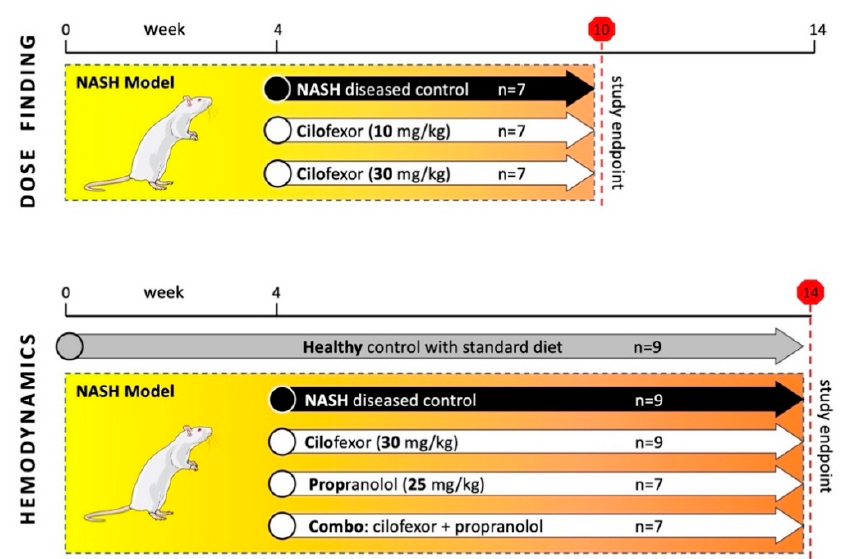
Figure 1. Study design and treatment groups. The NASH model was induced by choline-deficient high-fat diet and injection of NaNO 2 3 × /week. Initially, a 10-week long dose-finding study was performed with three groups of 7 rats each. The animals received placebo treatment, 10 mg/kg or 30 mg/kg of cilofexor (CILO), respectively, from weeks 4–10. In a subsequent, 14-weeks-long study, four NASH groups ( n = 7–9) received placebo, 30 mg/kg cilofexor, 25 mg/kg propranolol or a combination of the latter two compounds (Combo) from weeks 4–14 to investigate effects on hepatic hemodynamics.